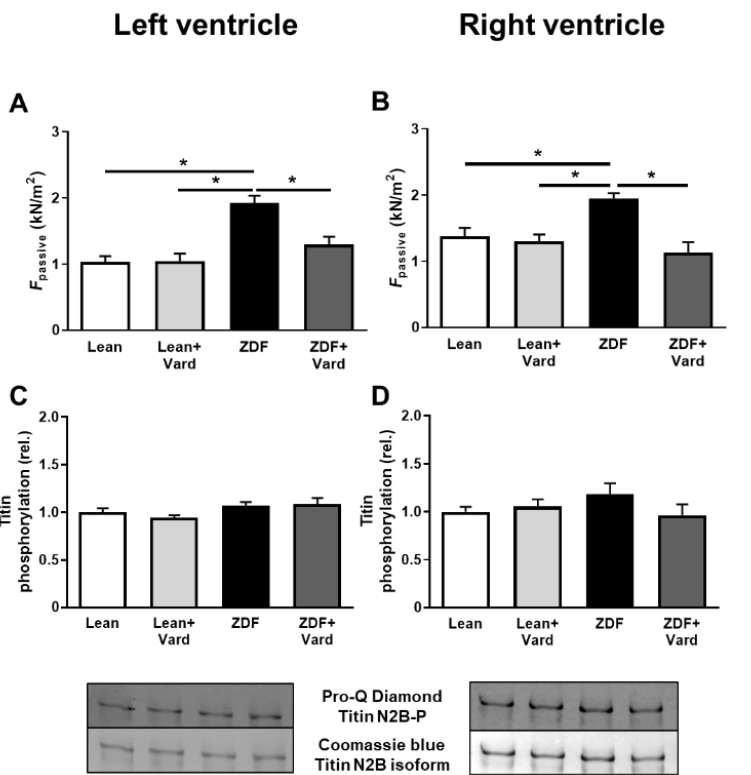
Figure 2. Cardiomyocyte passive tension (F passive ) and titin protein phosphorylation in the left ( A , C ) and right ( B , D ) ventricles in the four experimental groups. F passive was measured at a sarcomere length of 2.3 µ m ( A , B ) ( n = 6–11 cardiomyocytes from at least three different hearts/groups). Overall phosphorylation level of the N2B titin isoform was assessed by Pro-Q ® Diamond phosphoprotein staining. Titin amounts were visualized by Coomassie-blue staining ( C , D ). F passive values: LV Lean, 1.03 ± 0.09 kN/m 2 ; LV Lean + Vard, 1.05 ± 0.11 kN/m 2 ; LV ZDF, 1.98 ± 0.12 kN/m 2 ; LV ZDF + Vard, 1.30 ± 0.12 kN/m 2 ; RV Lean, 1.38 ± 0.12 kN/m 2 ; RV Lean + Vard, 1.29 ± 0.11 kN/m 2 ; RV ZDF, 1.95 ± 0.08 kN/m 2 , RV ZDF + Vard, 1.13 ± 0.16 kN/m 2 ). Overall titin phosphorylation levels: LV Lean, 1.00 ± 0.04; LV Lean + Vard, 0.94 ± 0.03; LV ZDF, 1.07 ± 0.03; LV ZDF + Vard, 1.09 ± 0.06; RV Lean, 1.00 ± 0.05; RV Lean + Vard, 1.05 ± 0.08; RV ZDF, 1.19 ± 1.11; RV ZDF + Vard, 0.96 ± 0.11; all in relative units. Data are given as mean ± SEM, * p < 0.05.